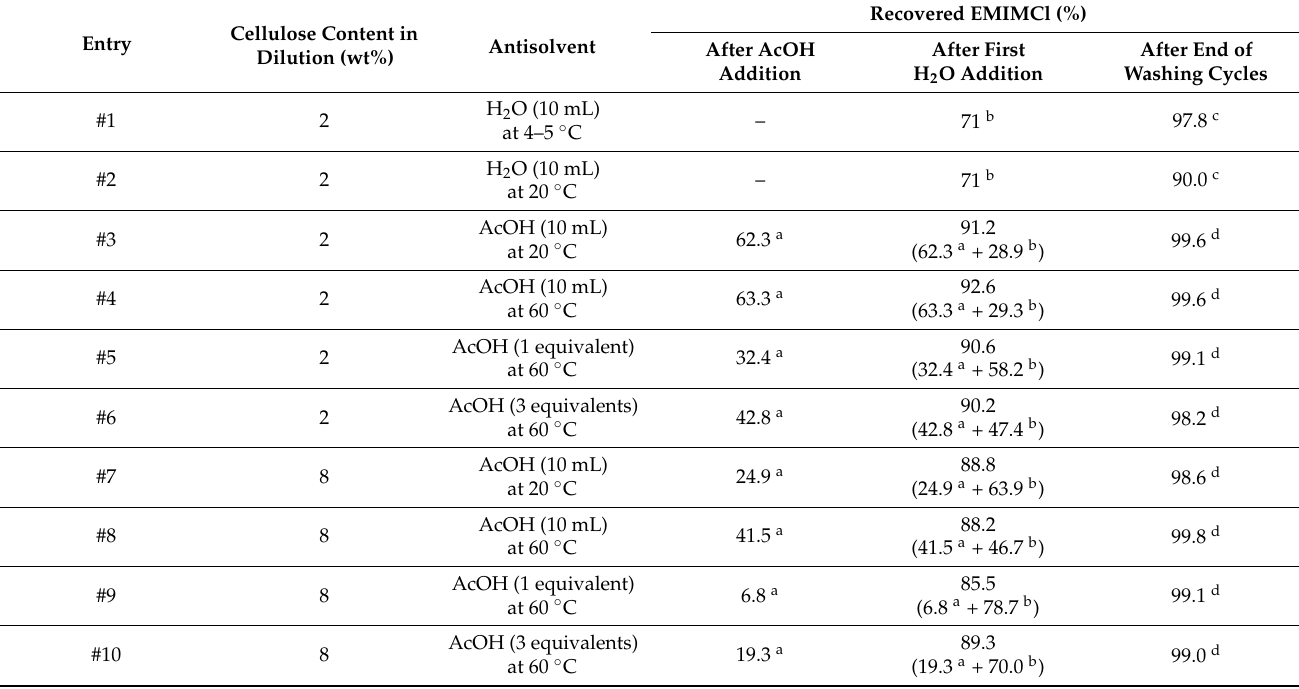
Table 1. Data of recovered EMIMCl after cellulose precipitation from EMIMCl dilutions with 2 and 8 wt% cellulose